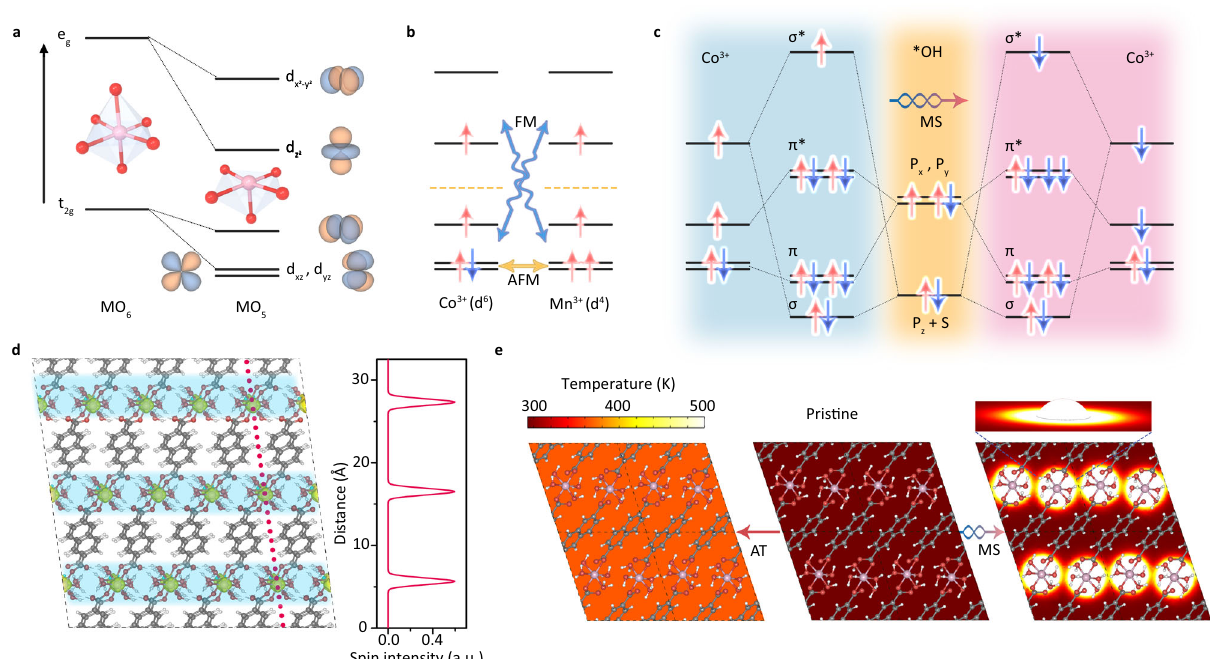
Fig. 1 Reaction mechanism design. a Electron con fi guration of 3d orbital. b Magnetic exchange sketch. c The orbital interaction between Co and *OH under different spin con fi guration. d The spin density distribution of Co 0.8 Mn 0.2 -MOF. e The theoretical simulation of heating process between conventional annealing treatment and magnetic